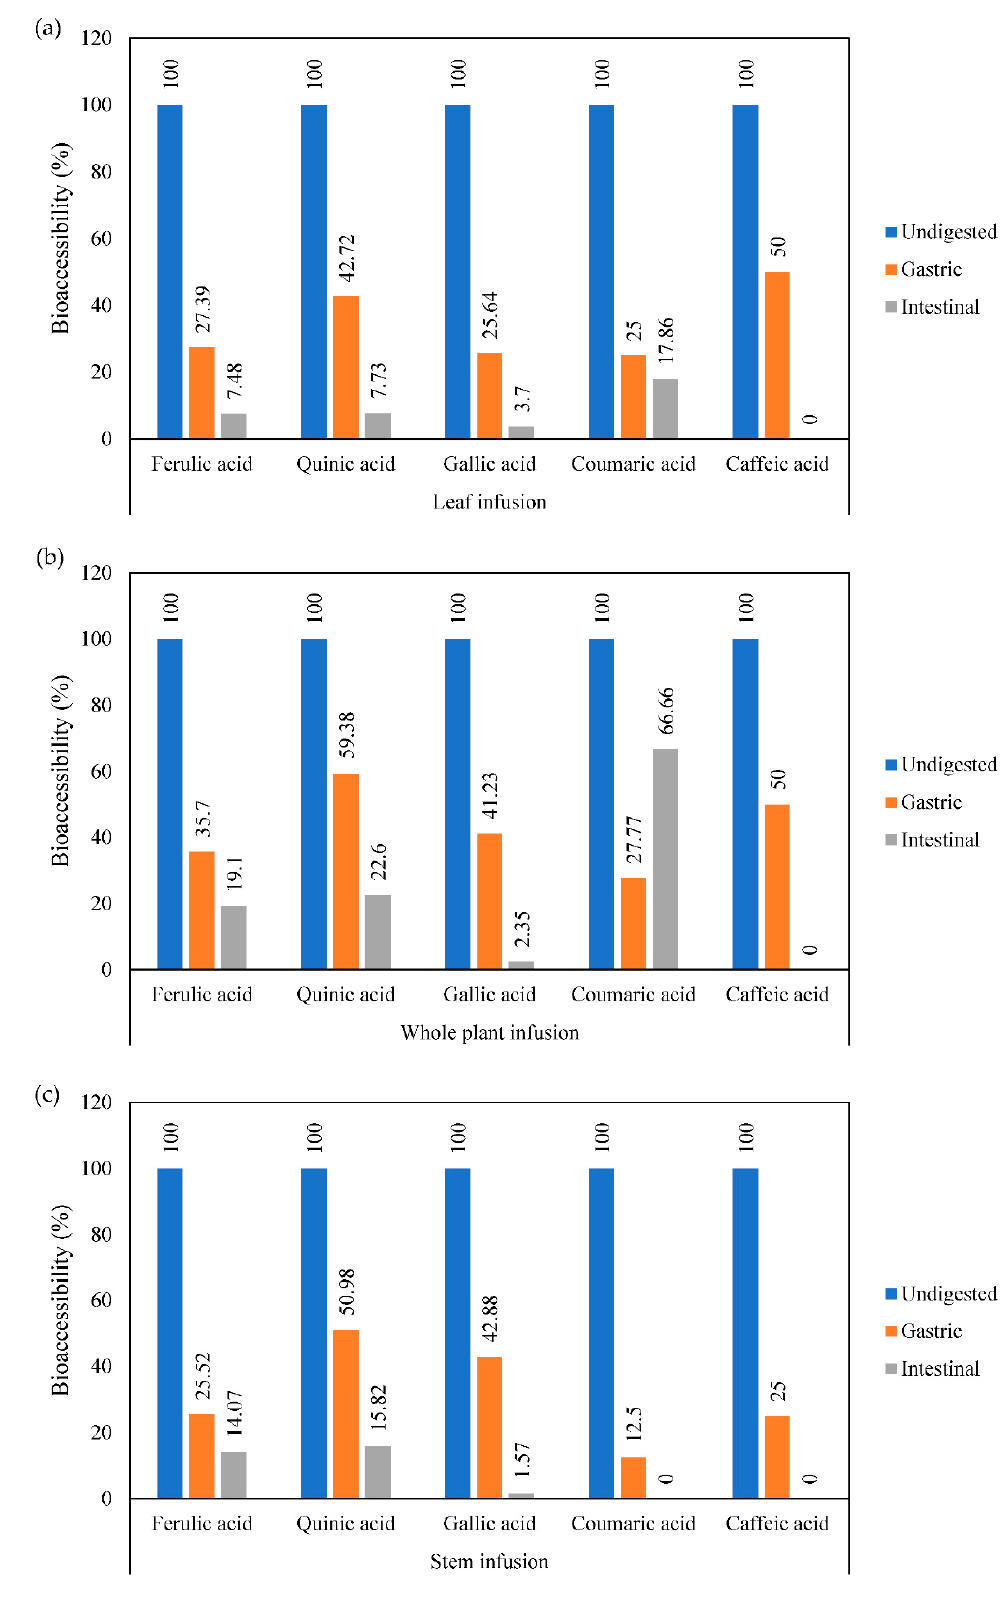
Figure 1. Bioaccessibility of phenolic acids from mistletoe ( a ) leaf infusion, ( b ) whole plant infusion, and ( c ) stem infusion subjected to simulated in vitro digestion.